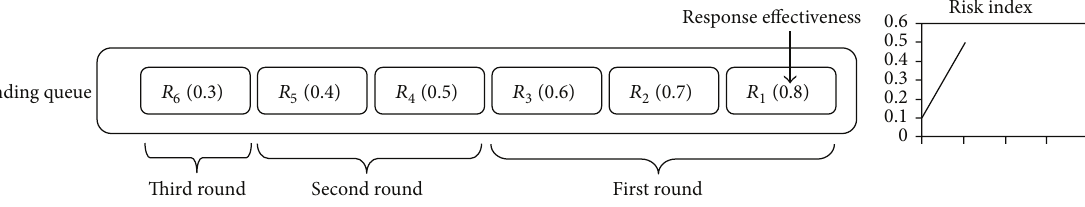
Figure 2: Pending queue in 𝑅𝑢𝑛 𝑝𝑙𝑎𝑛𝑠 process before starting the first round of responses.